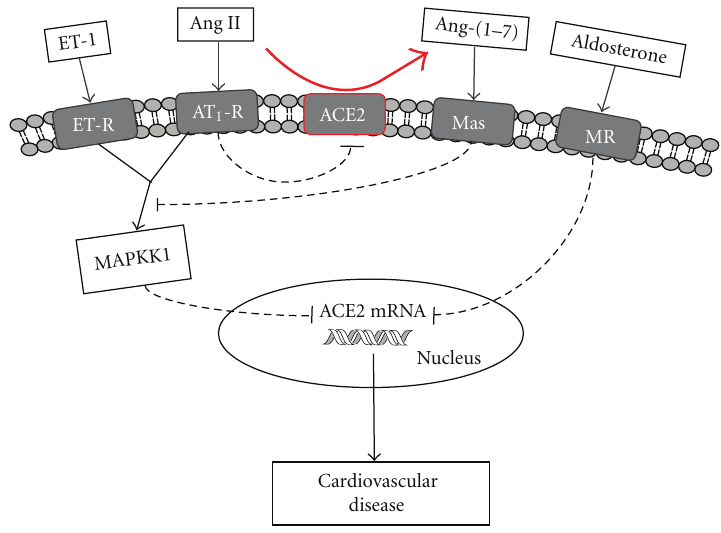
Figure 2: Schematic illustration of ACE2 modulation in cardiomyocytes by di ff erent molecules. Ang II, and ET-1 through MAPKK1 activation, and aldosterone lead to ACE2 mRNA downregulation. To date no reported e ff ects of Ang-(1-7) on ACE2 levels have been demonstrated, although this peptide is capable of antagonizing Ang II and ET-1 e ff ects on ACE2 mRNA. Conditions that favor ACE2 downregulation would likely lead to more deleterious e ff ects during cardiovascular disease development. → = activation; - - (cid:3) = inhibition; ET-1 = endothelin; Ang II = angiotensin II; Ang-(1-7) = angiotensin-(1-7); ET-R = endothelin receptor; AT 1 -R = AT 1 receptor; Mas =